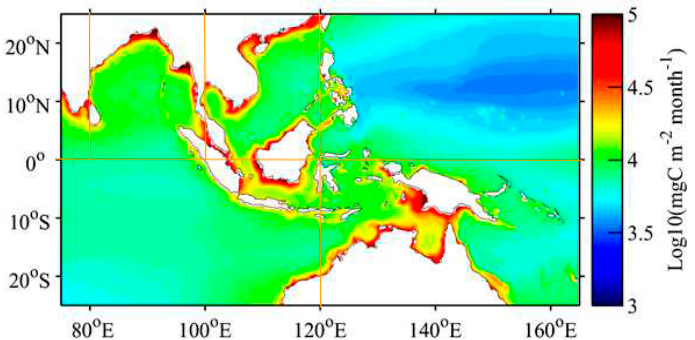
Figure 1. Climatological ocean net primary production (NPP) during 1998–2016 in the study area, derived based on SeaWiFS and MODIS Chla using the VGPM algorithm.